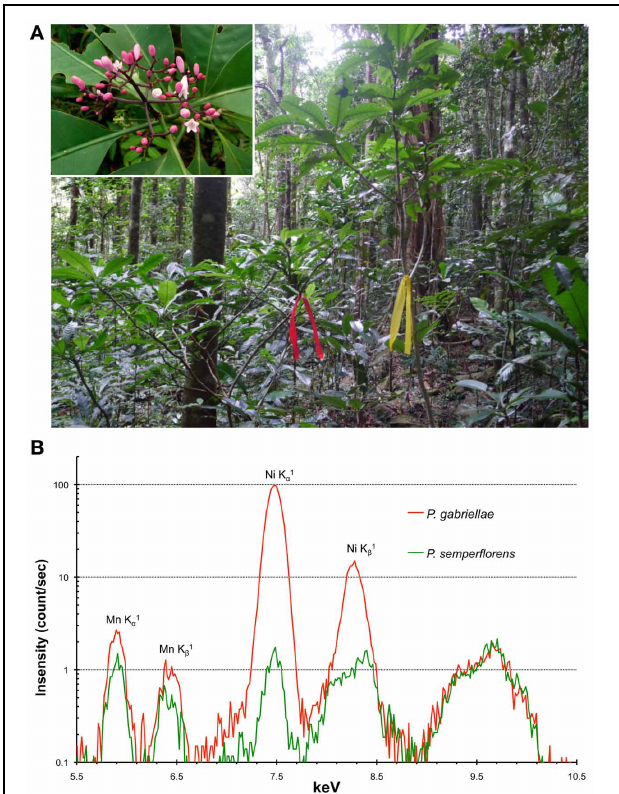
FIGURE 2 | Psychotria gabriellae and Psychotria semperflorens as a model system to study nickel hyperaccumulation. The Ni hyperaccumulator P. gabriellae (red tag) and the closely related non-accumulator P. semperflorens (yellow tag) are living in sympatry in rain forest on ultramafic soil in New Caledonia (A) . Both species are 1–3 meters shrub with very similar pink flowers (top right insert: P. semperflorens inflorescence). In natural growth condition, P. gabriellae accumulates up to 4% Ni in leaves while P. semperflorens accumulates approximately 100 times less Ni. These differences can be semi-quantitatively visualized on XRF spectra (B)